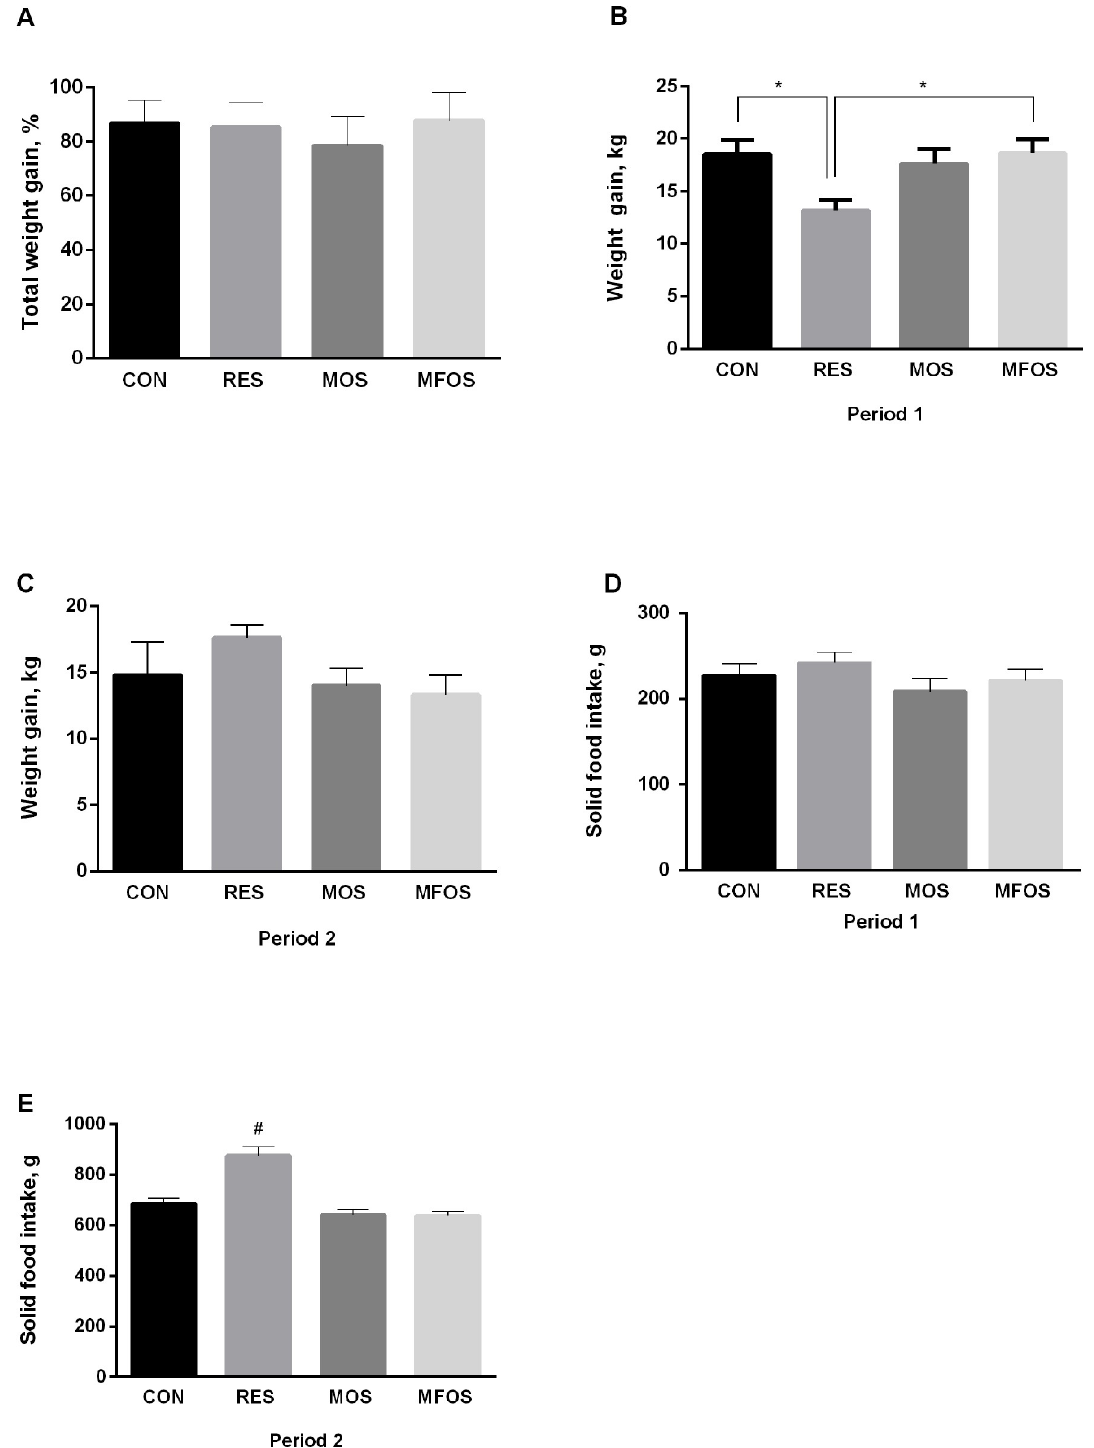
Fig 1. Calves weight gain and solid food intake. The average weight gain during periods 1 (day 1–28) and 2 (day 29–56) (Fig 1B and 1C, respectively), the total weight gain at the end of experiments (Fig 1A) and solid food intake during periods 1 and 2 (Fig 1D and 1E, respectively) of calves underwent milk restriction or supplemented with prebiotics. Data are presented as mean ± the standard error of the mean (SEM). � P < 0.05; # P < 0.05 vs. other groups. CON–control calves that received 6 L of milk/day for 56 days. RES–calves received restriction milk (3 L/day) for 28 days (Period 1) followed by 6 L milk/day for 28 days (Period 2). MOS–calves supplemented